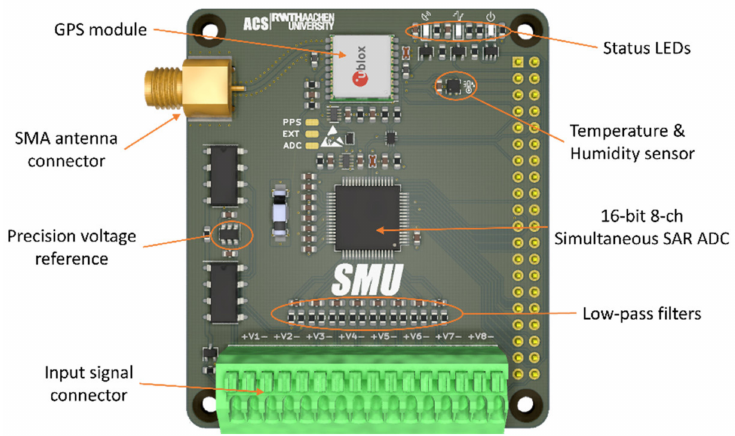
Figure 2. SMU hardware-attached-on-top module for Raspberry Pi 3 and main board